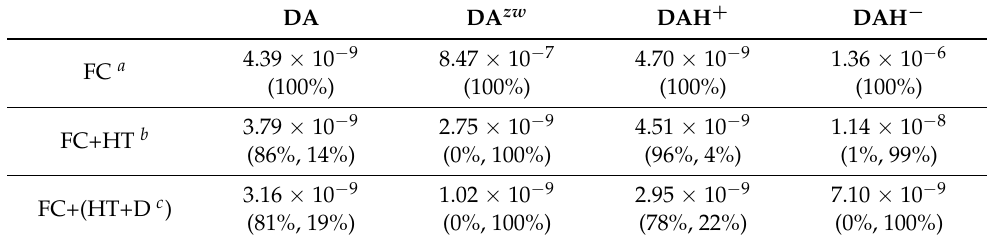
Table 3. Fluorescence lifetimes (in seconds) defined as the inverse of the radiative transition rate obtained for the four DA species at the ω B97X-D3/ma-def2-TZVPP level of theory. (The contribution of Franck–Condon and Herzberg–Teller approximations is given in